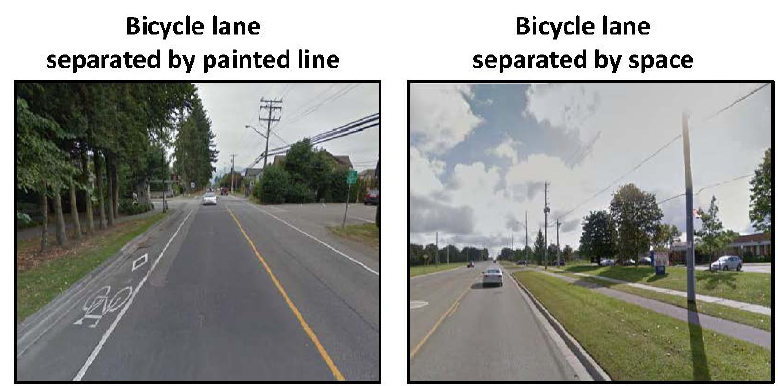
Figure 4. Google Street View images of bicycle